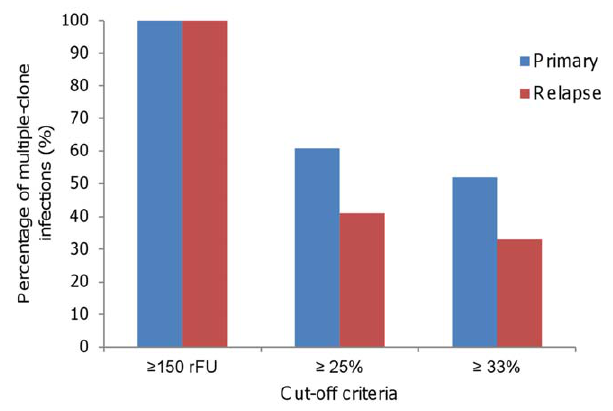
Figure 5. Percent of multiple-clone infections using different cut-off criteria. The detection of rare alleles in the genotyping was based on three cut-off criteria: $ 150 rFU (here); peaks with more than one quarter [46]; or with more than one third of the predominant peak height [47].